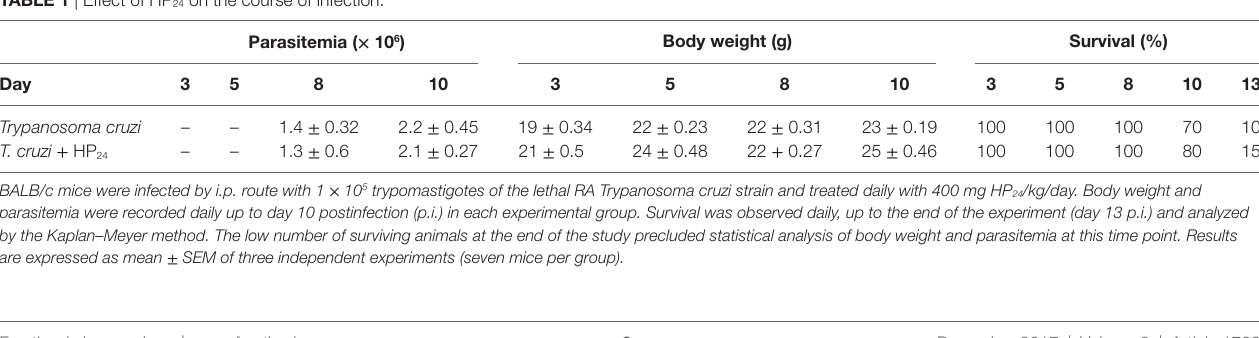
TaBle 1 | Effect of HP 24 on the course of infection.